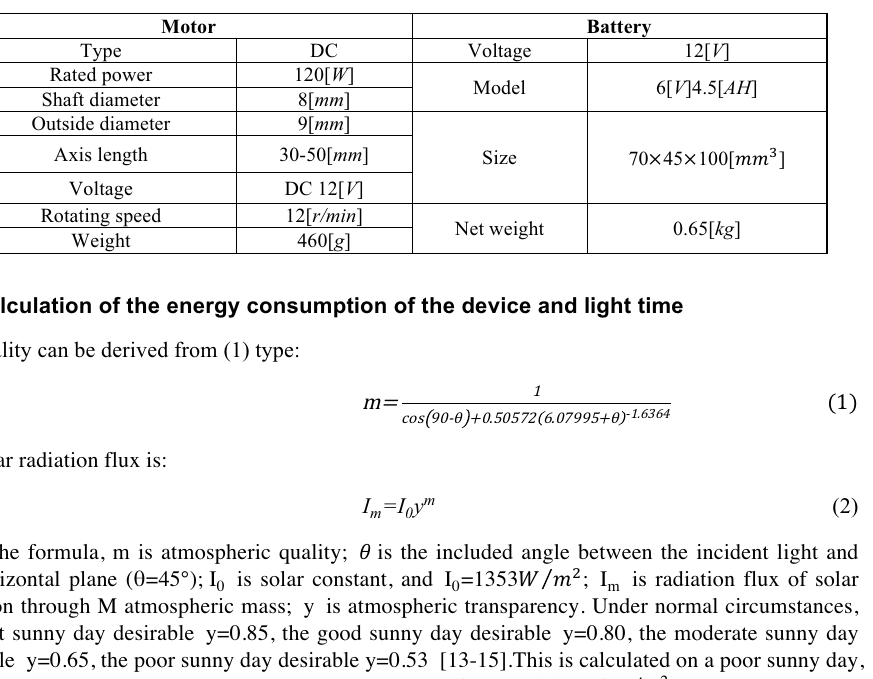
Table 1. The parameters of the motor and the